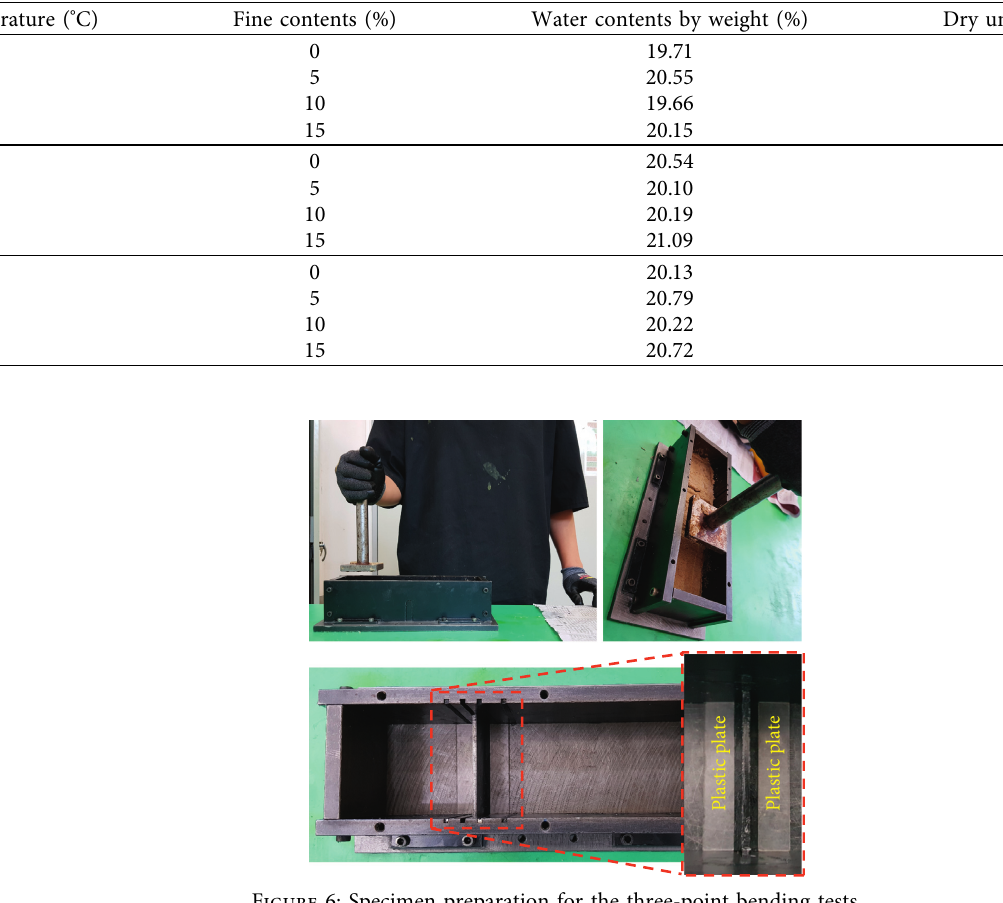
Table 2: Summary of the water contents and dry unit weight of the specimens.